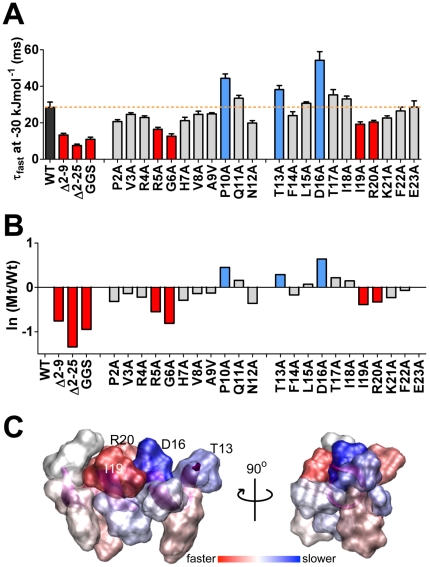
Summary comparing rates of channel deactivation for point mutations within the N–terminal tail.Deactivation rates (τ
fast) compared at an equivalent electrochemical driving force -(ΔG0–zg
EF) of −30 kJmol–1. Data represented as mean ± SEM (panel A) or as ratio with WT hERG (panel B). Mutant constructs (Δ2–9, Δ2–25 and GGS) and point mutations (R5A, G6A, I19A, and R20A) that significantly enhanced rates of deactivation compared to WT (black bar) are shown in dark red, while point mutations (P10A, T13A and D16A) that slow deactivation are shown in dark blue (ANOVA p<0.05). C. Representation of the N–terminal α–helical region with residues colored depending on the severity of deactivation phenotype after mutation to alanine. Residues with the most severe alterations to deactivation rates (T13, D16, I19 and R20) clustered on the same face on the α–helix.